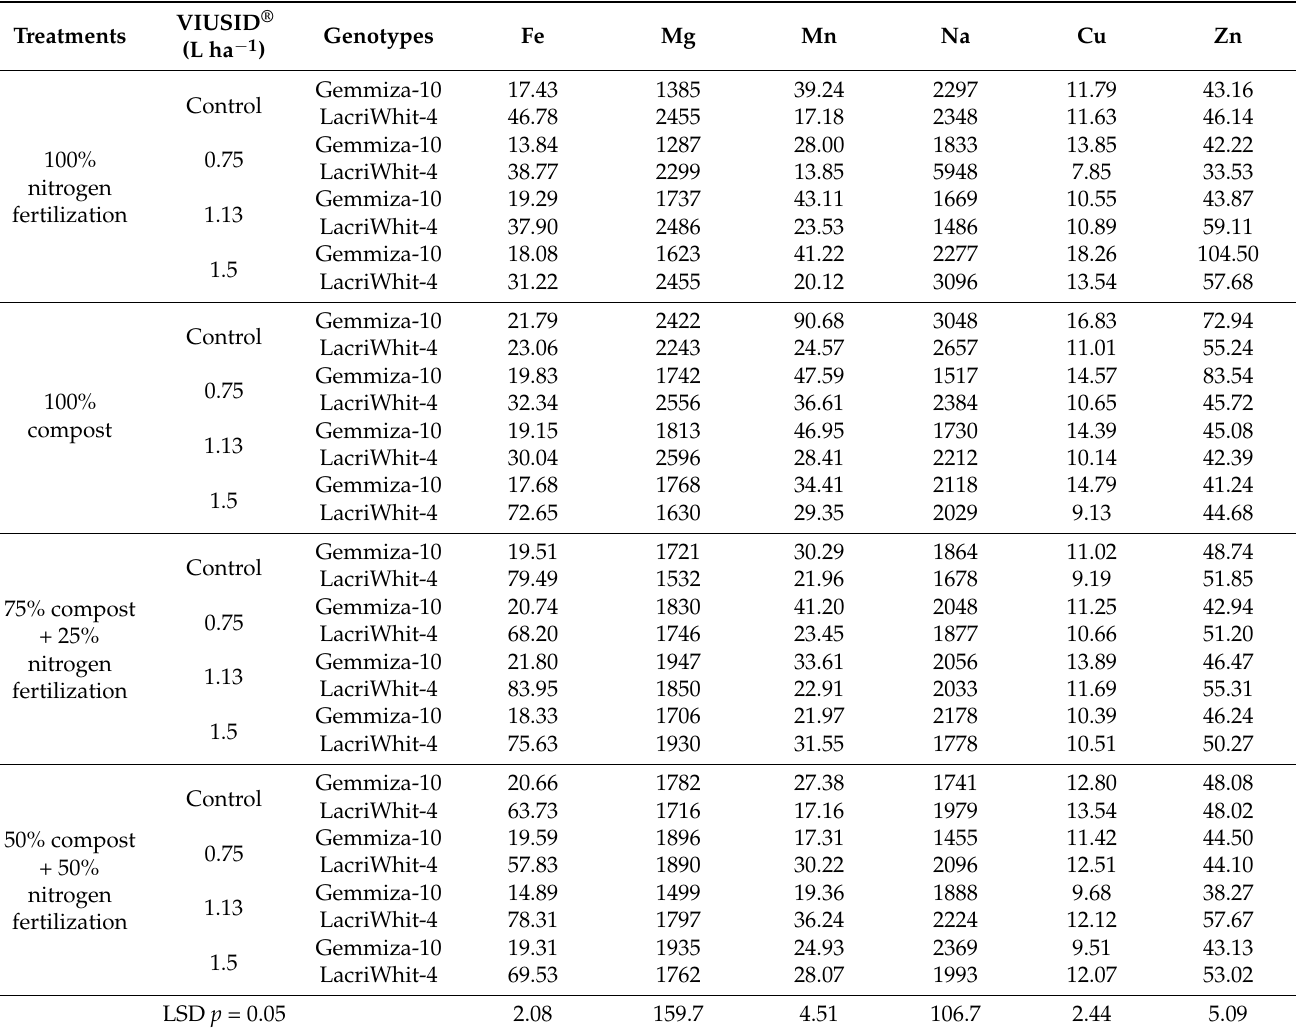
Table 9. Effect of different levels of compost, foliar application of VIUSID ® agro and two wheat cultivars on micronutrient contents of grain